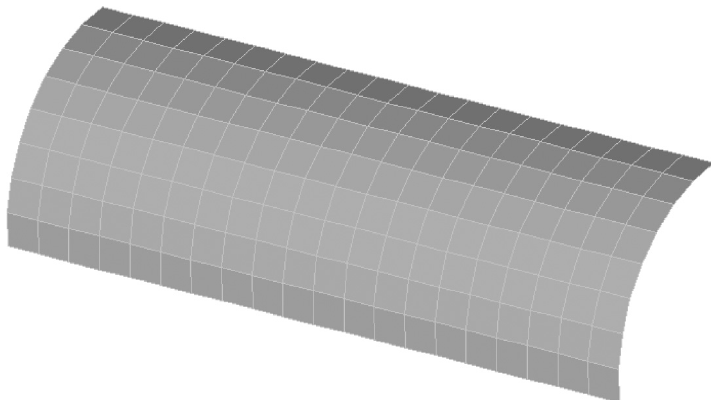
Fig. 13. Finite element mesh of an octant of the